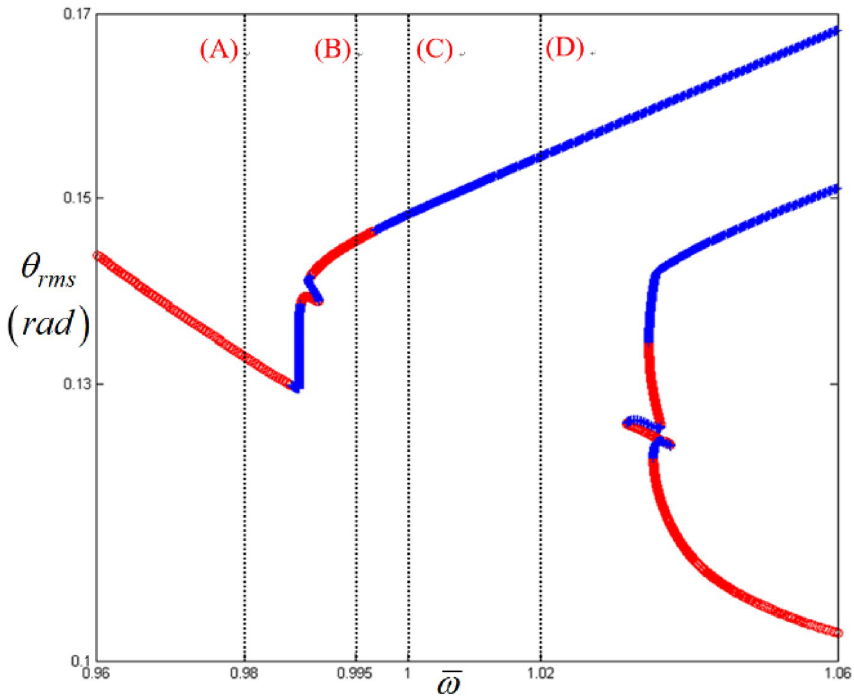
Figure 9. Nonlinear frequency responses focused on sub-harmonic regimes with RMS values. Key: circle, stable solutions; plus, unstable